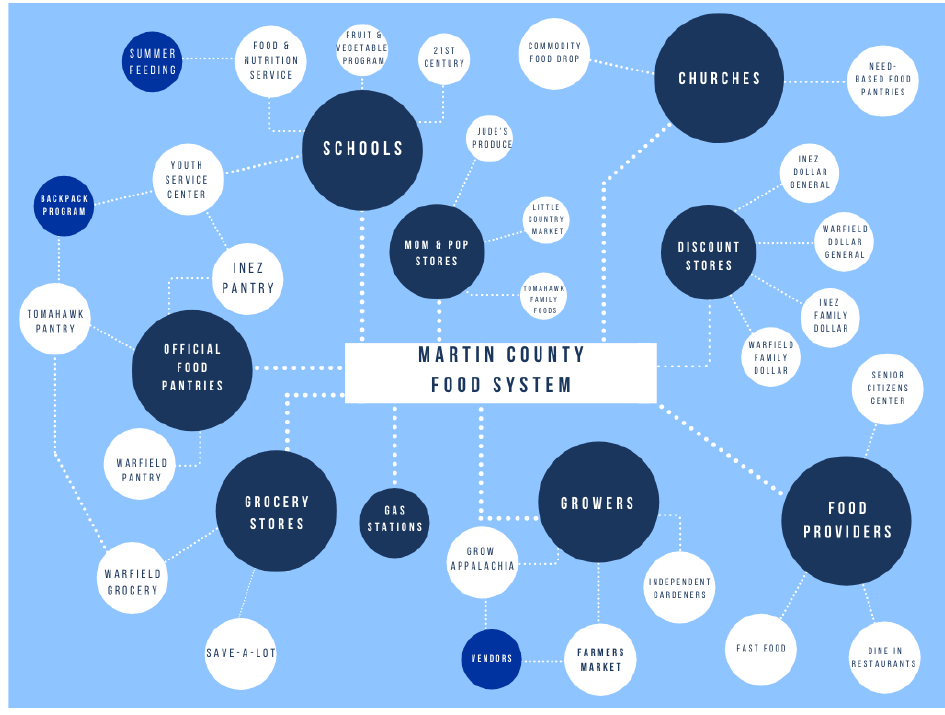
Figure 1. Martin County Food System.